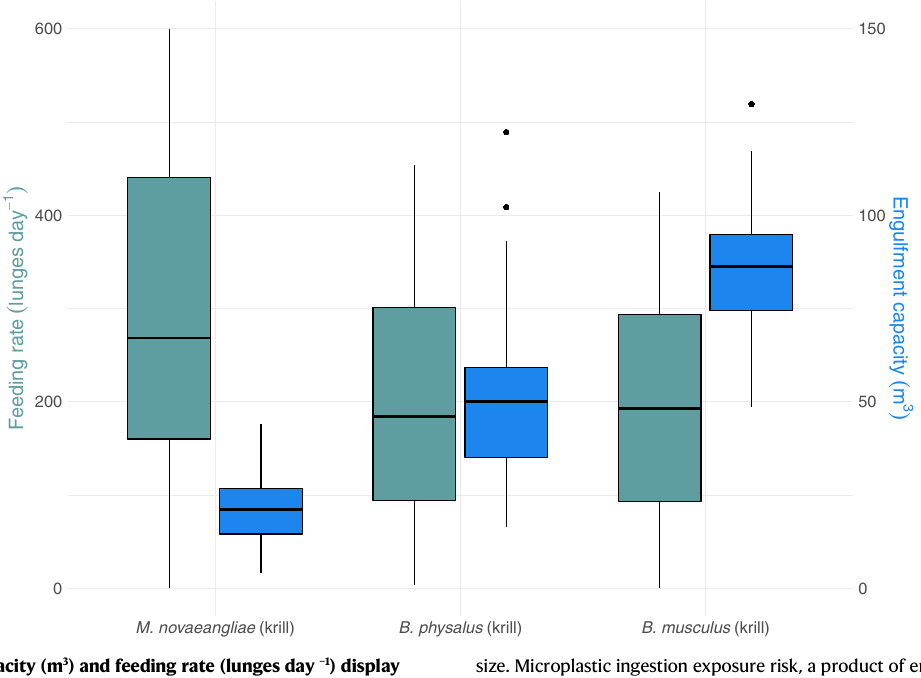
size. Microplastic ingestion exposure risk, a product of engulfment capacity and feeding rates, is likely also body-size dependent. Data are presented as median values and interquartile range (25th − 75th). Source data are provided as a Source Data fi